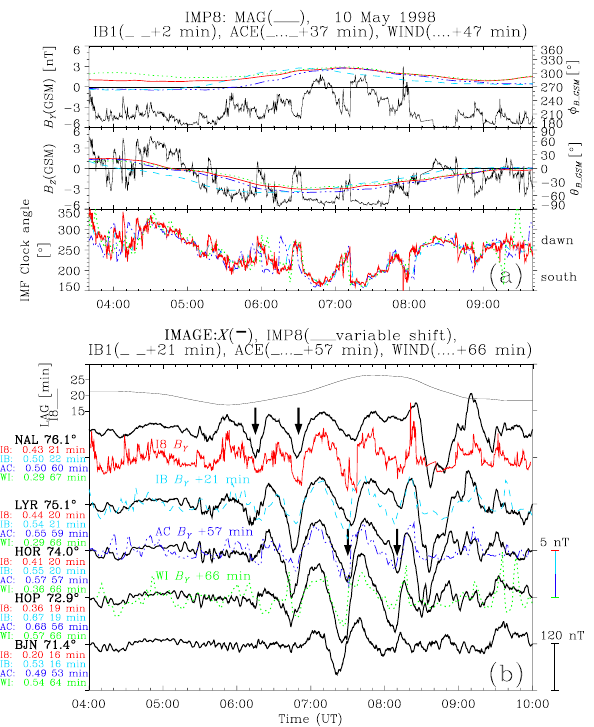
Fig. 3. (a) The IMF B Y , B Z (IMP-8), clock angle and the mean IMF orientation angles ϕ B and θ B . The INTERBALL (light blue), ACE (dark blue) and WIND (green) time series are shifted relative to IMP-8 (black or red). (b) The detrended X component of the ground magnetic field (black heavy lines) measured by the IMAGE (Svalbard) magnetometer array. The curve at the top shows the vari- able lag obtained from the correlation between the IMP-8 IMF B Y and NAL ground magnetic field X component using an advancing 1-h window. Detrended and time shifted IMF B Y time series mea- sured by IMP-8 (variable shift), INTERBALL 1, ACE and WIND are superposed. The maximum correlation coefficients and corre- sponding average lags are shown on the left. The arrows indicate the intensifications of the westward DPY current.